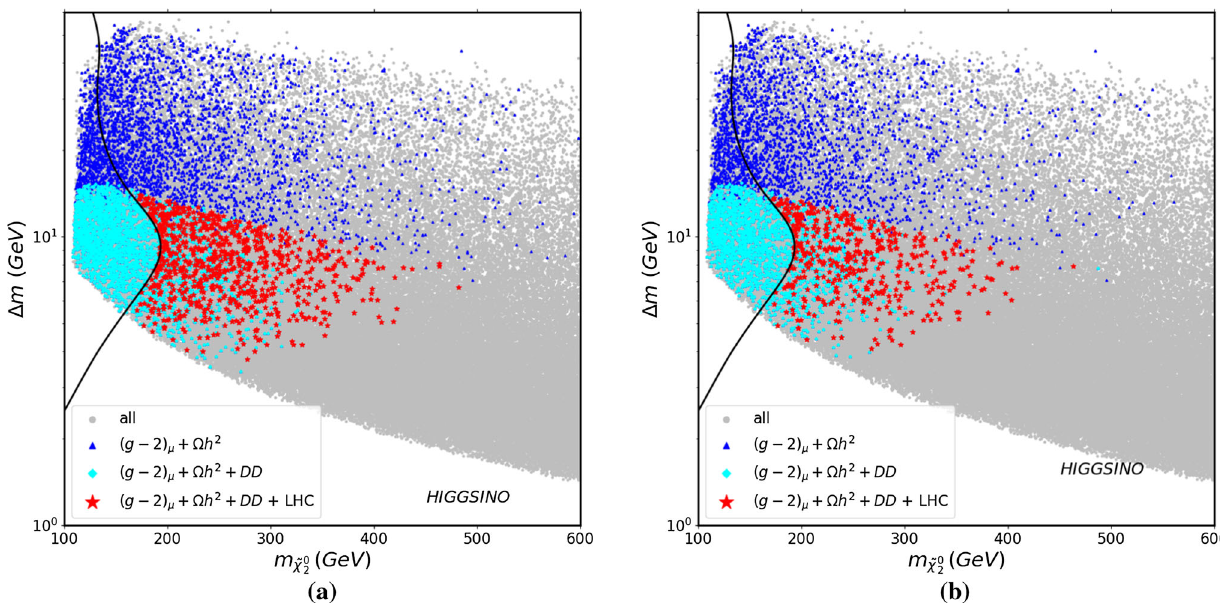
− m ) plane for the higgsino DM scenario for current (left) and anticipated – (cid:6) m ( = m ˜ χ 0 ˜ χ 0 2 2 1